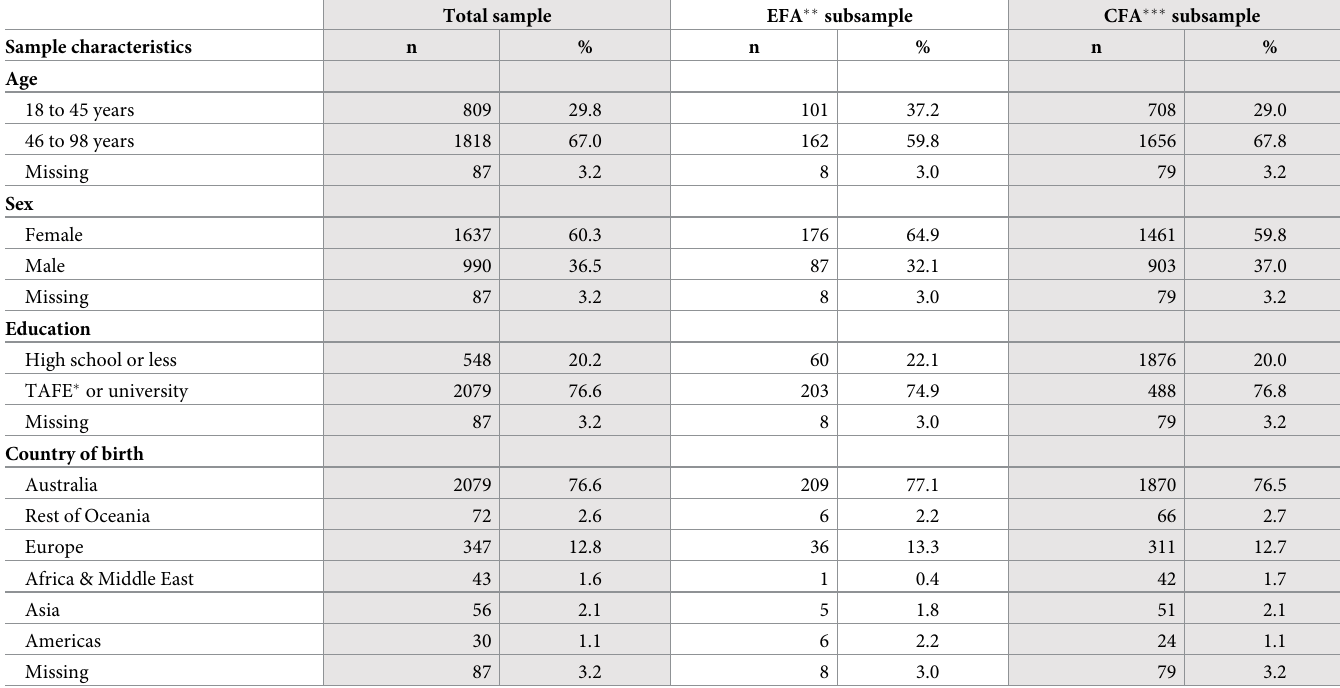
Table 1. Characteristics of study participants (n =